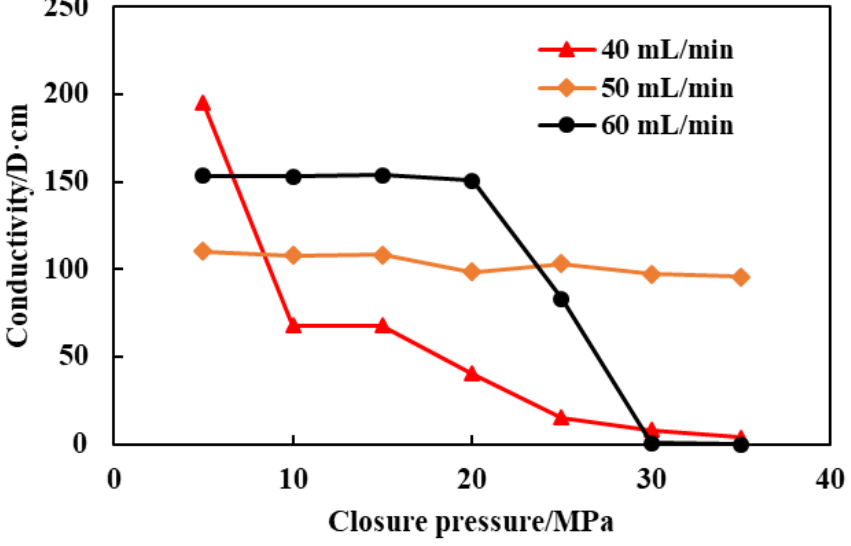
Figure 11. Variation of conductivity with closure pressure at different injection rates.